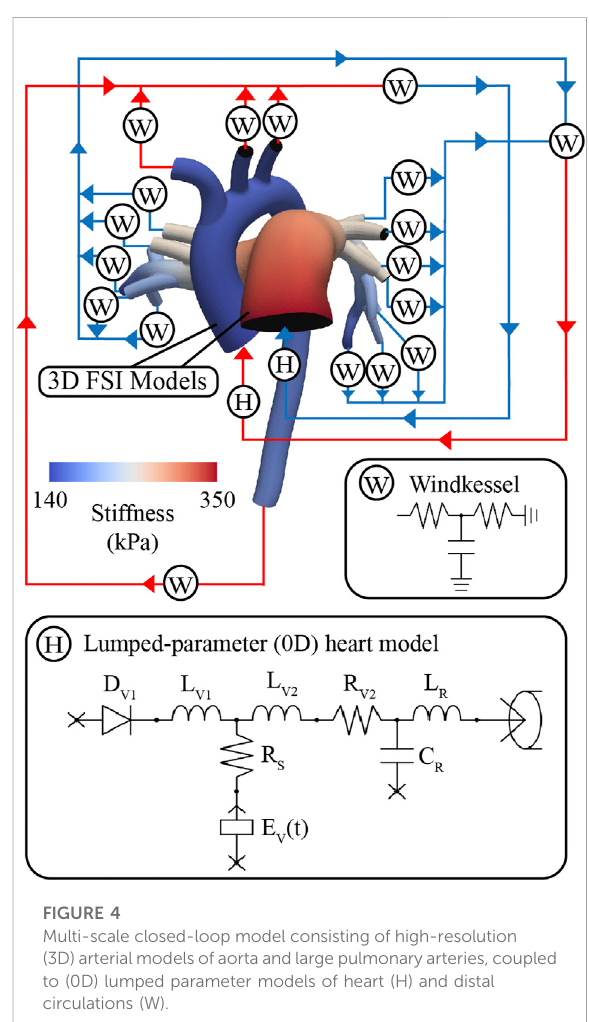
FIGURE 4 Multi-scale closed-loop model consisting of high-resolution (3D)arterialmodelsofaortaandlarge pulmonary arteries,coupled to (0D) lumped parameter models of heart (H) and distal circulations